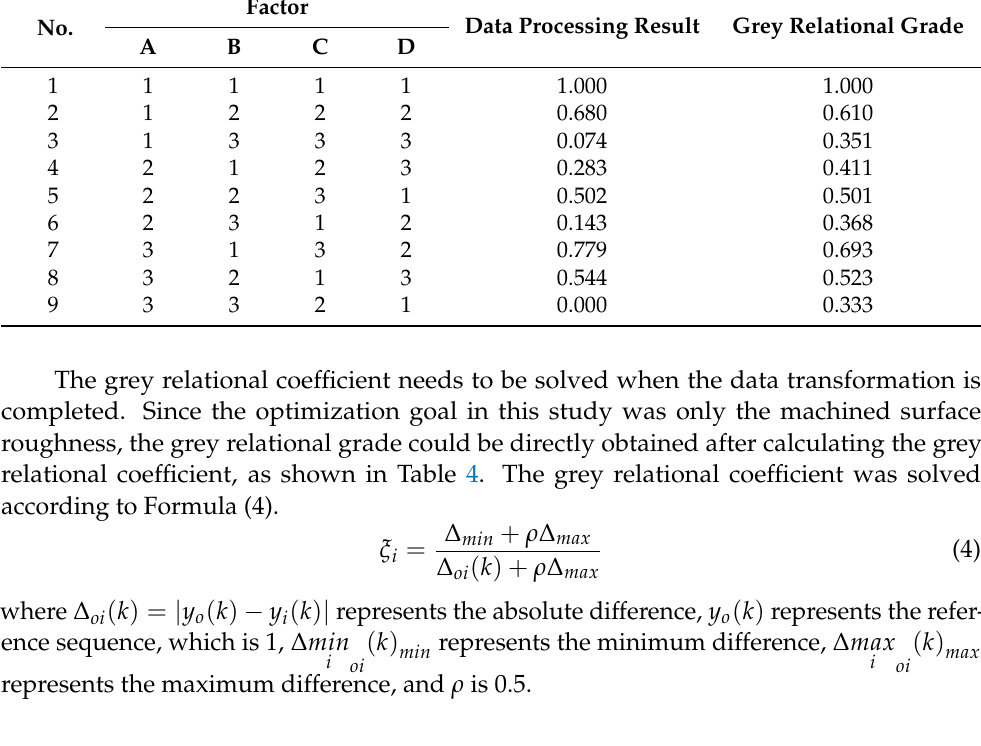
Table 4. Data processing result and grey relational grade. Factor Data Processing No.